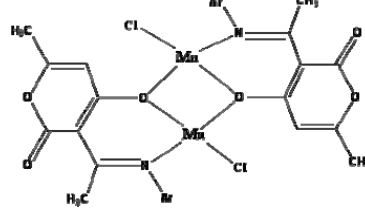
Figure 2. The proposed geometry of Mn(II) complexes